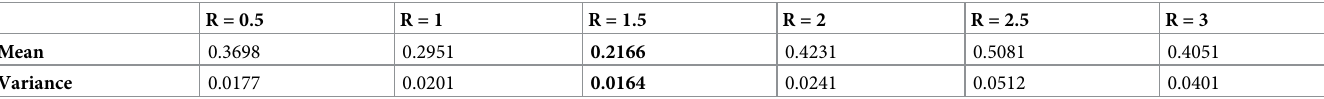
Table 9. Experimental data of IGD metric for comparative radius. R =